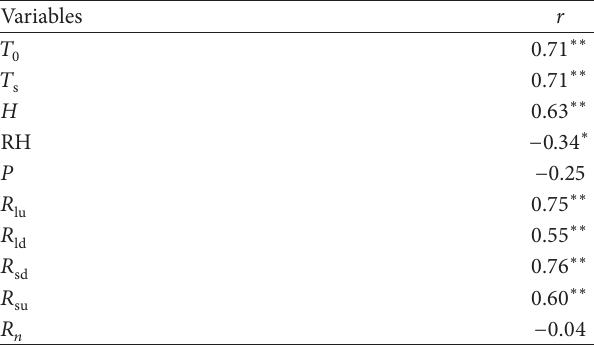
Table2:Statisticalcorrelationsbetweentheaveragesofatmospheric variables and boundary layer height during 10:00 and 18:00 BJT ( 𝑇 0 : surface air temperature; 𝑇 s : surface temperature; H : sensible heat flux; RH: surface relative humidity; P : atmospheric pressure; 𝑅 𝑅 𝑅 𝑅 lu , su , ld , and sd : upward long wave and short wave radiation and downward long wave and short wave radiation, resp.; 𝑅 𝑛 : net radiation; r : Pearson correlation